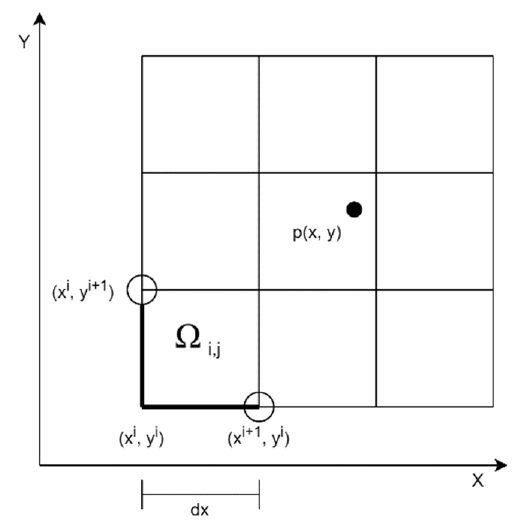
Figure 5. Dividing the area into